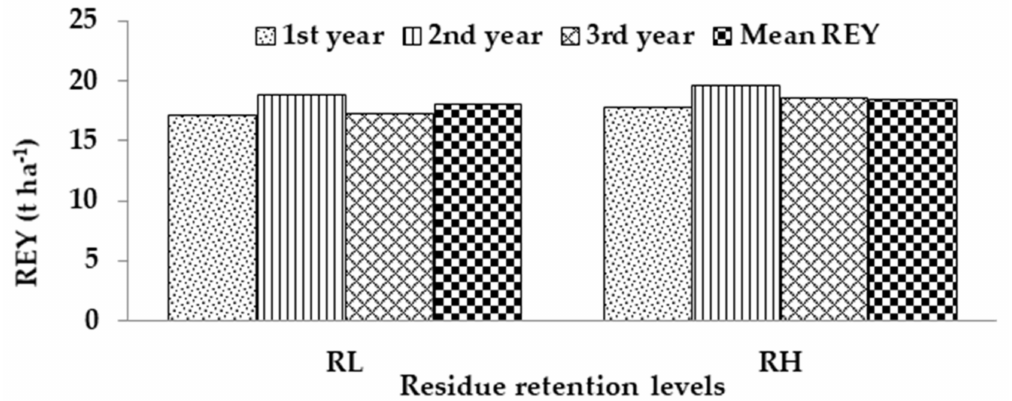
Figure 3. Effect of residue retention levels on rice equivalent yield. RL = low residue retention, RH = increased residue